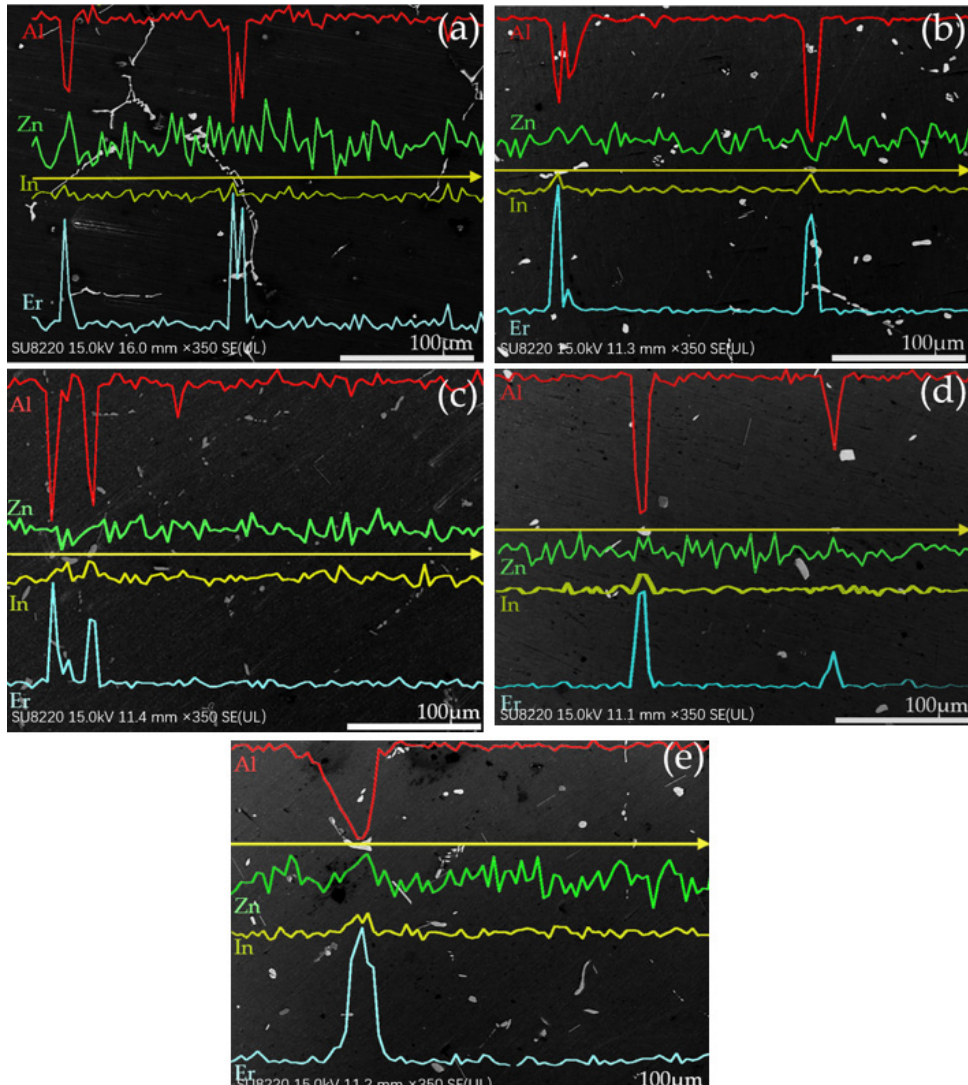
Figure 10. Line scanning analysis of the as-cast Al-5Zn-0.03In-1Er alloy and after treatment at 615 °C for different times: ( a ) as-cast, ( b )16 h, ( c ) 24 h, ( d ) 32, ( e ) 40 h.